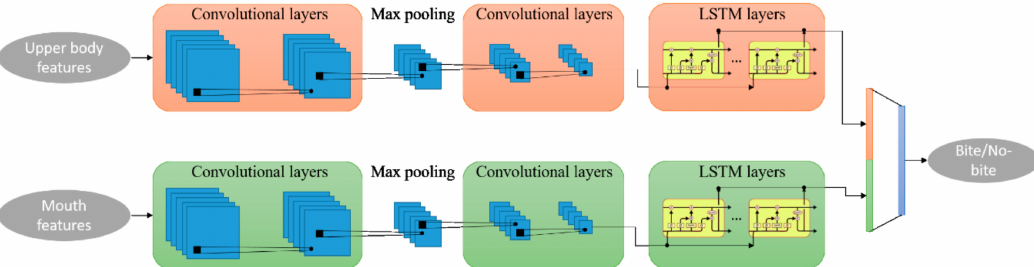
Figure 4. Schematic representation of the RABiD algorithm, for the parallel analysis of upper body (including the head) and mouth movements in videotaped meals. The outcome of the algorithm is